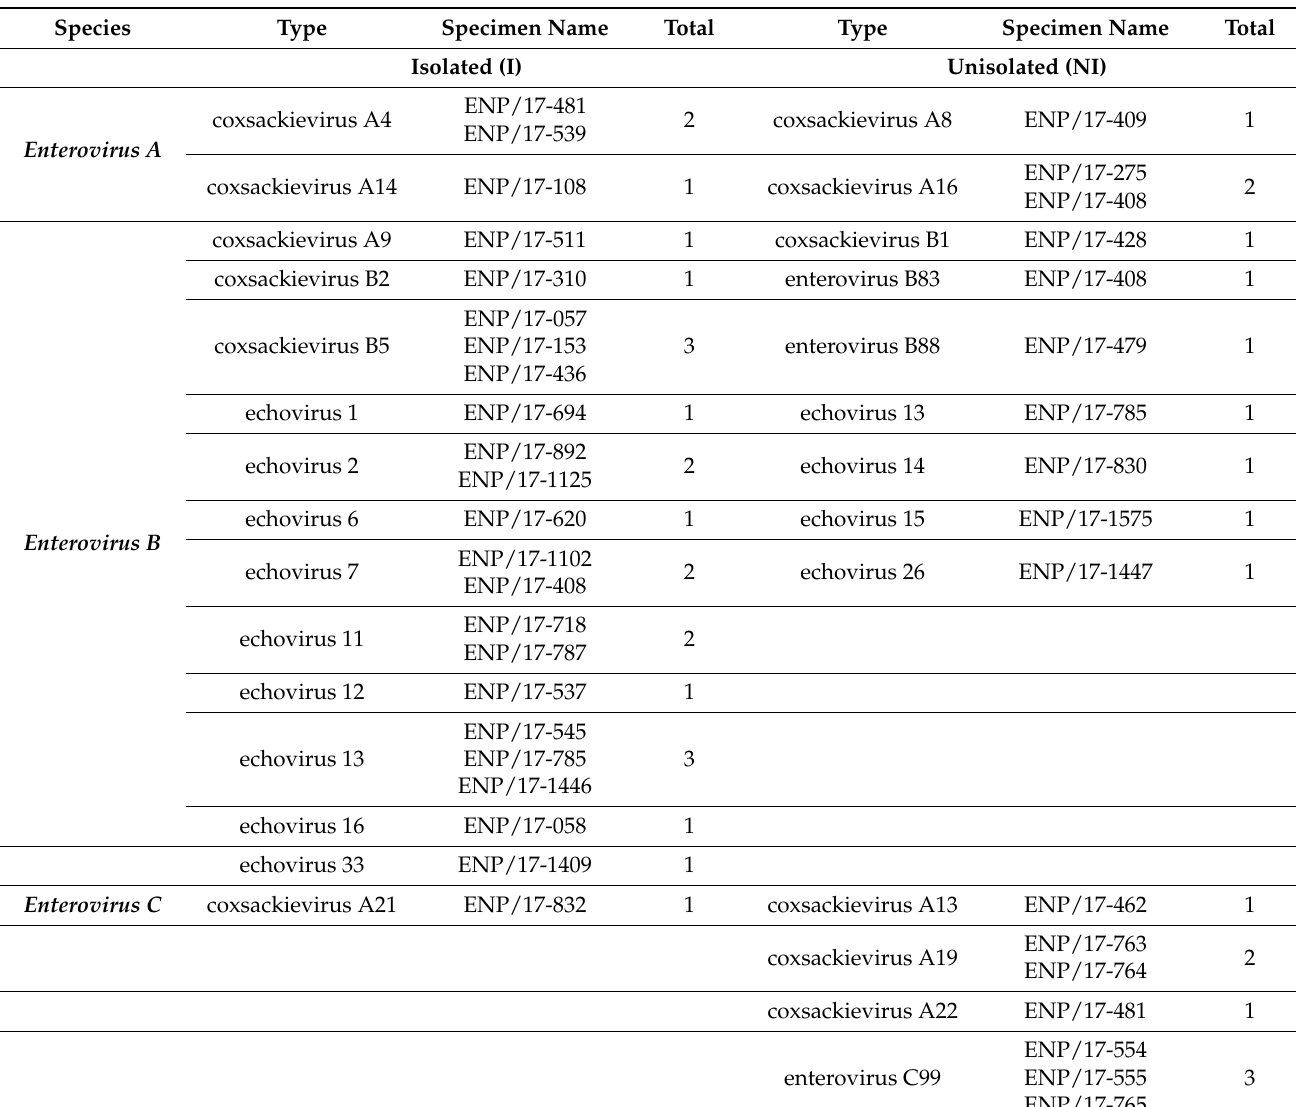
Table 1. Sequencing results of non-polio enteroviruses and their